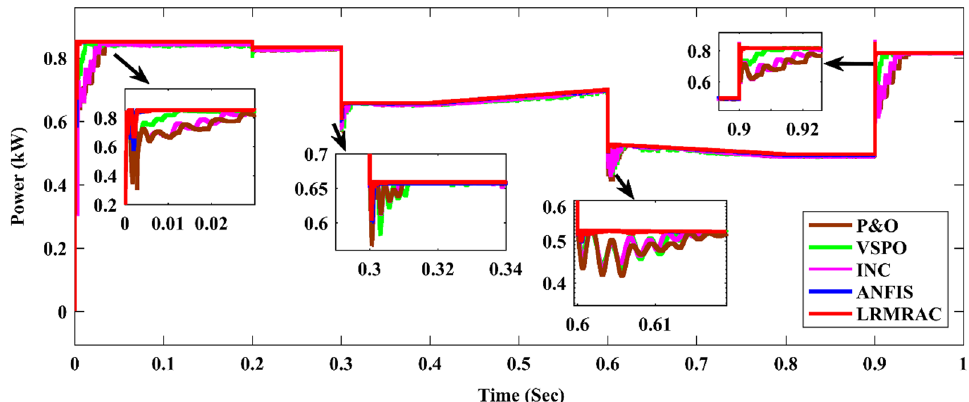
Fig. 16 PV power using the five MPPT algorithms while temperature and radiation change at